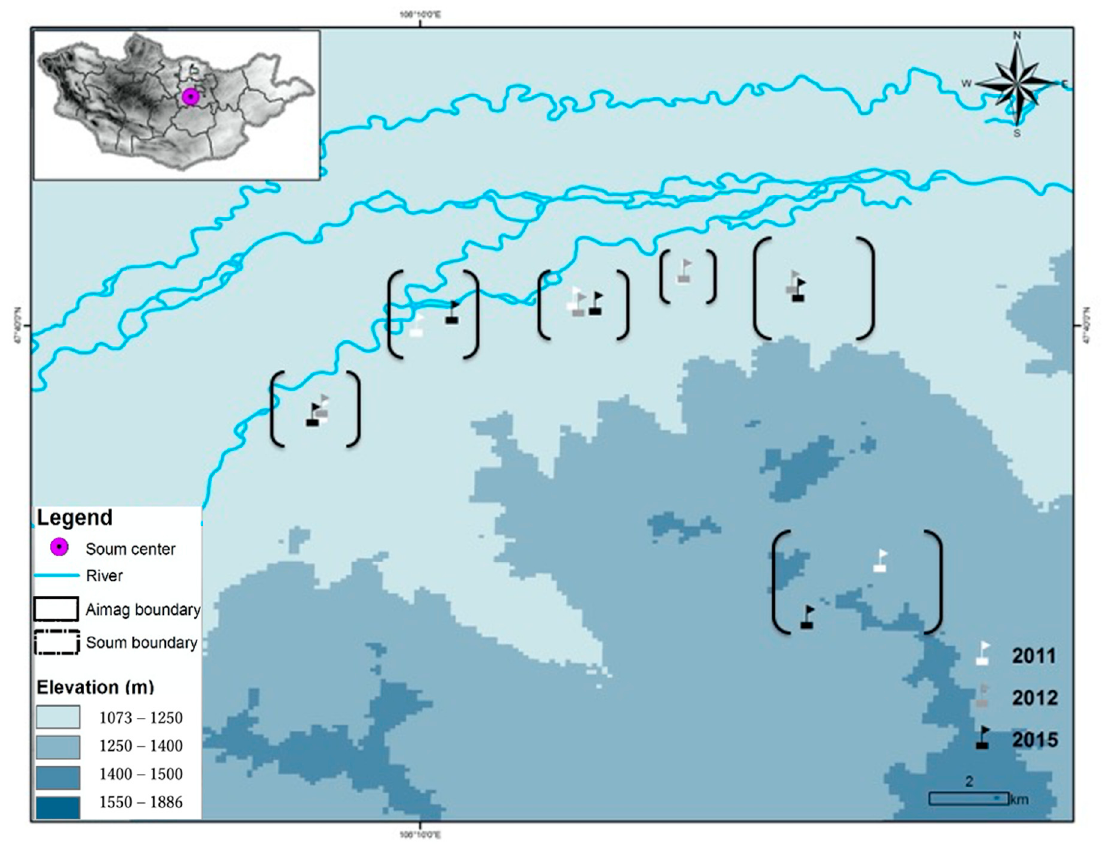
Figure 4. Annual change in the summer camp location of six households.